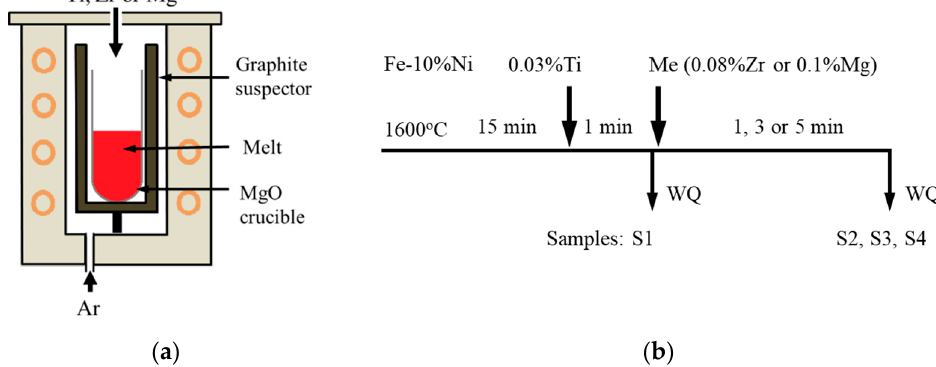
Figure 1. Schematic illustration of experimental setup ( a ) and main operations during experiments ( b ).